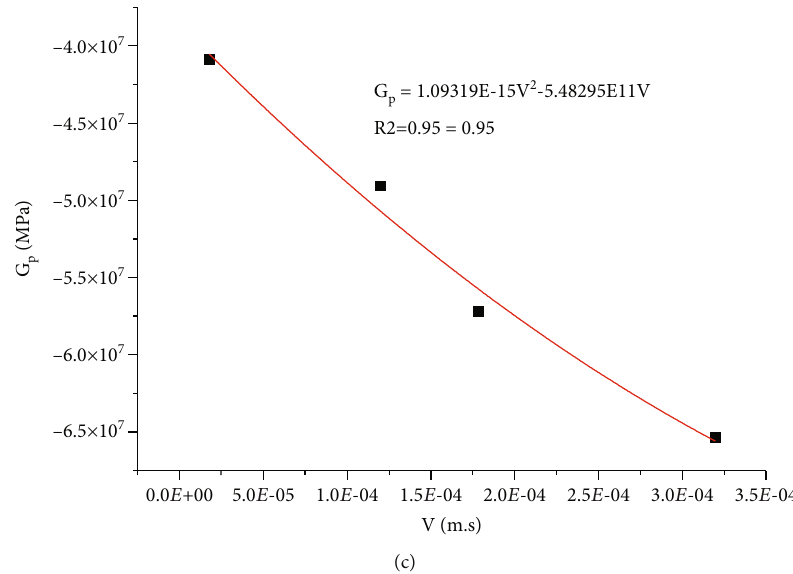
V of the fi lling gangues with a particle size of 0 ~ 5 mm at di ff erent axial loads: (a) 4 MPa, (b) 6 MPa, Figure 7: Fitted curves between G p and and (c) 8